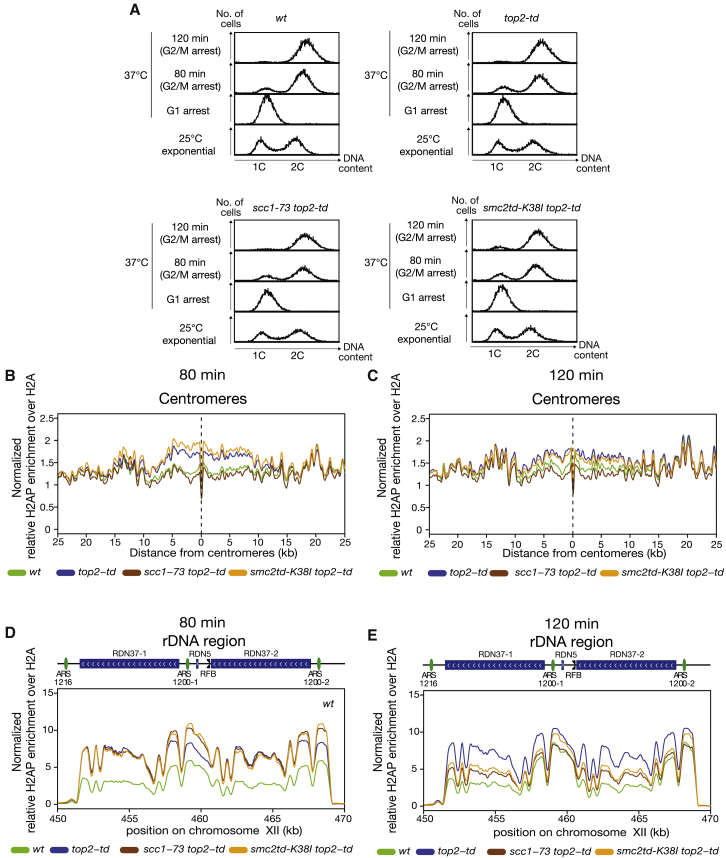
Quantitative ChIP-Seq of H2AS129P around Centromeres and rDNA Shows that Cohesin and Condensin Activity Affects Rate of Repair across the rDNA(A) FACS analysis of one repeat for wild type, top2-td, scc1-73 top2-td, or smc2-td K38I top2-td at 25°C exponential followed by restrictive conditions in a G1 arrest and released under restrictive conditions for both 80 min and 120 min. Second repeat is shown in Figure S7.(B) The relative enrichment of H2AS129P over H2A ChIP normalized to S. pombe spike in (see STAR Methods) around centromeres is shown for wild type (green), top2-td (blue), scc1-73 top2-td (brown), or smc2-td K38I top2-td (orange) all released into the cell cycle under the restrictive conditions for 80 min. Graph shown is generated from a pile up of the profiles of all centromeres and is an average of two repeats.(C) The relative enrichment of H2AS129P over H2A ChIP normalized to S. pombe spike in (see STAR Methods) around centromeres is shown for wild type (green), top2-td (blue), scc1-73 top2-td (brown), or smc2-td K38I top2-td (orange) all released into the cell cycle under the restrictive conditions for 120 min. Graph shown is generated from a pile up of the profiles of all centromeres and is an average of two repeats.(D) The relative enrichment of H2AS129P over H2A ChIP normalized to S. pombe spike in (see STAR Methods) across the rDNA repeats is shown for wild type (green), top2-td (blue), scc1-73 top2-td (brown), or smc2-td K38I top2-td (orange) all released into the cell cycle under the restrictive conditions for 80 min. Graph shown is an average of two repeats.(E) The relative enrichment of H2AS129P over H2A ChIP normalized to S. pombe spike in (see STAR Methods) across the rDNA repeats is shown for wild type (green), top2-td (blue), scc1-73 top2-td (brown), or smc2-td K38I top2-td (orange) all released into the cell cycle under the restrictive conditions for 120 min. Graph shown is an average of two repeats.See also Figure S4.